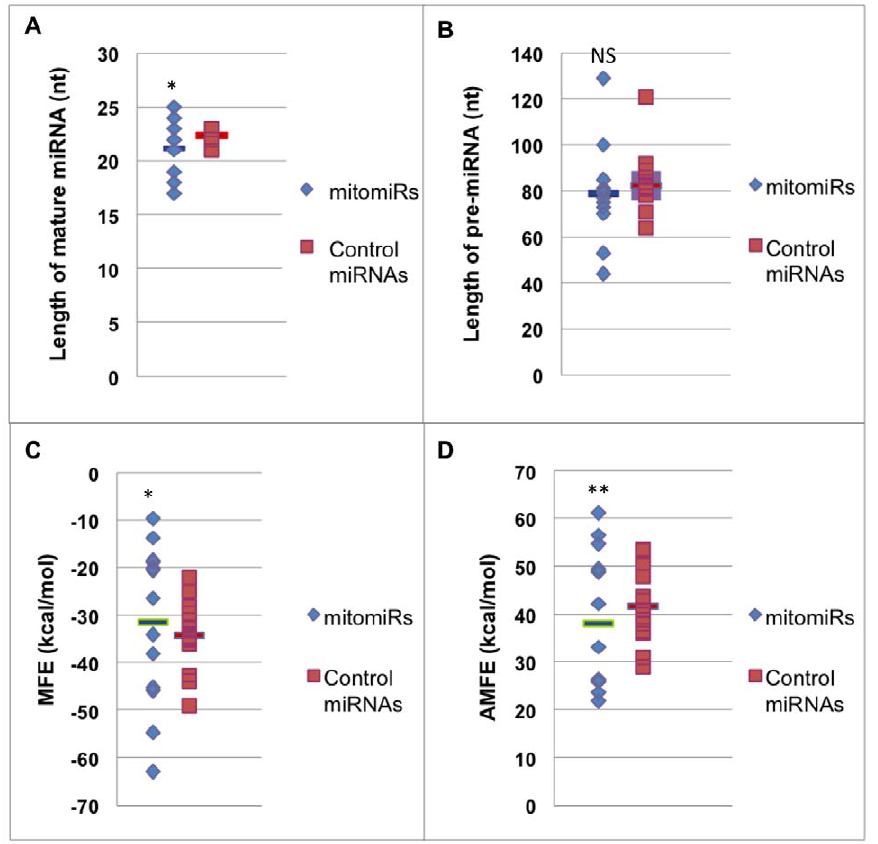
Figure 7. Intrinsic features of mitomiRs versus a control sample of cytosolic-enriched miRNAs. Values for each miRNA subgroup are shown in blue for the mitomiRs and red for the control miRNAs. Length of mature miRNAs (A) and of pre-miRNAs (B), and values of minimal folding free energy (MFE) (C) and adjusted MFE (AMFE) (D) are plotted for each miRNA from the 2 subgroups. Average values are shown as bars in each subgroup. Asterics indicate significant differences between mitomiRs versus control miRNAs (p-value , 0.05). NS indicates not significant p-value.